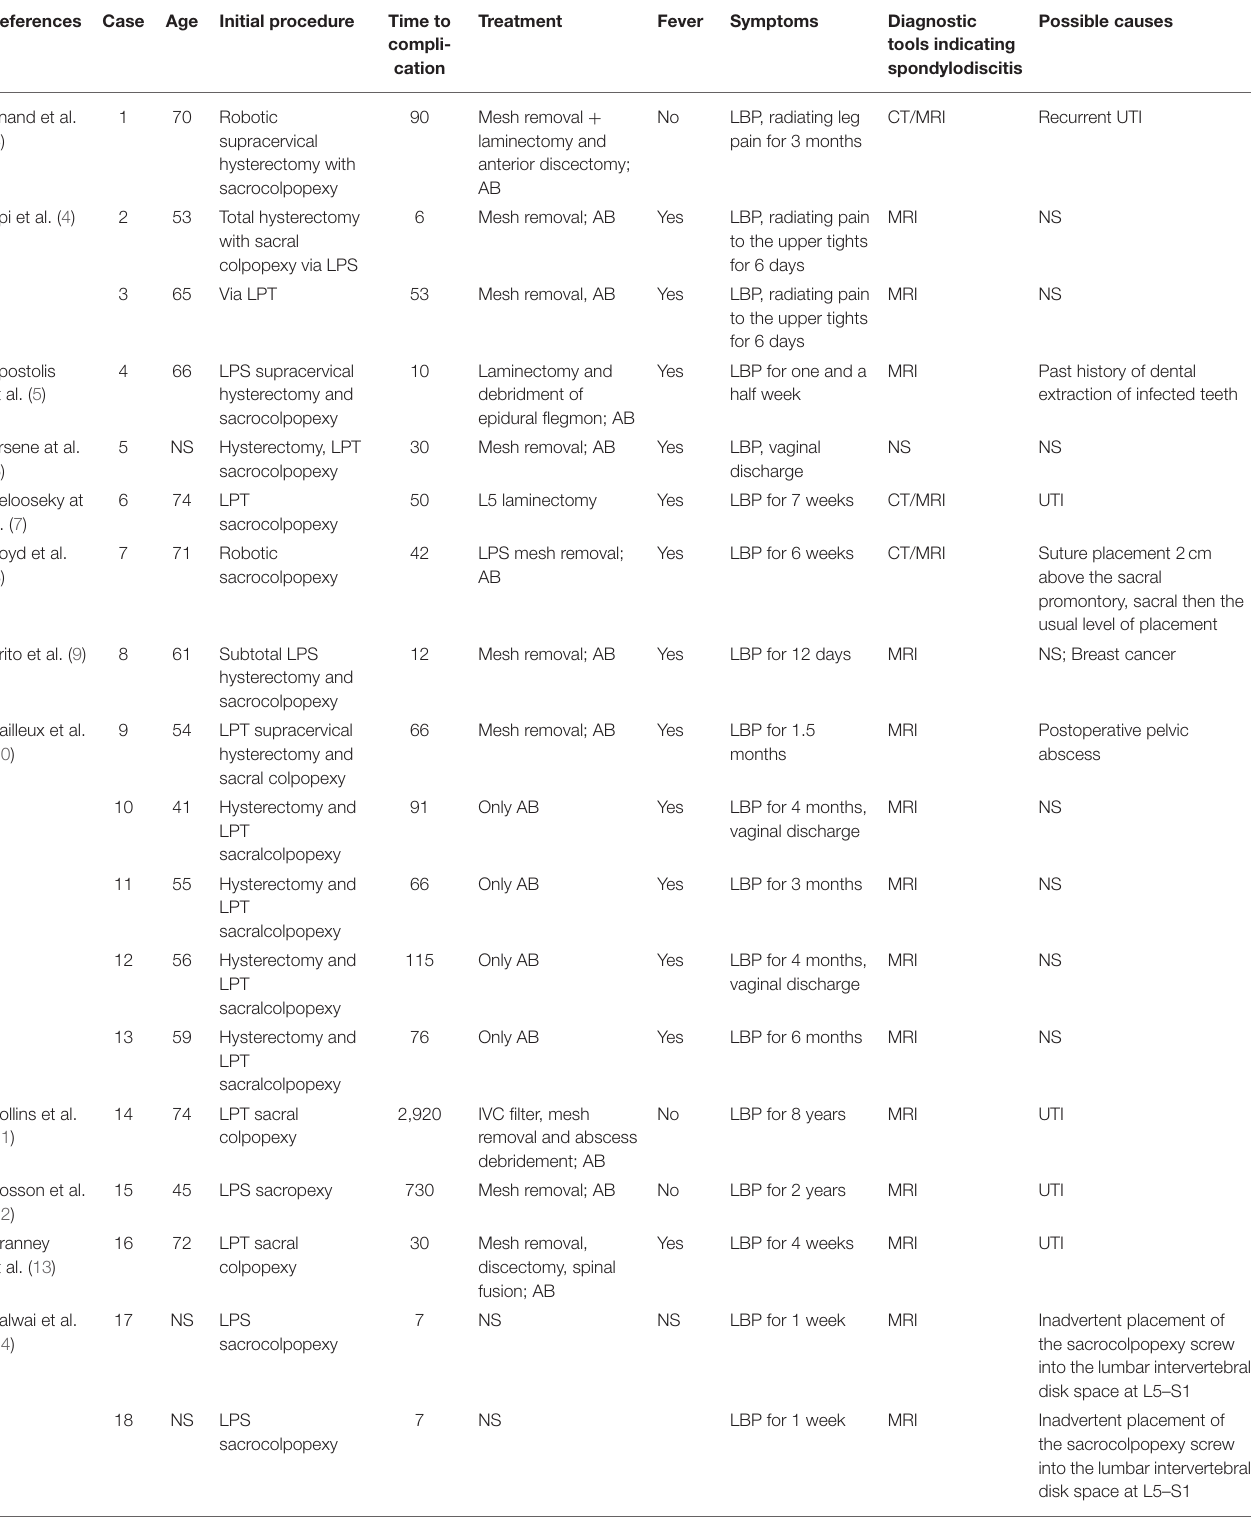
TABLE 3 | Studies included in the systematic review listed in alphabetic